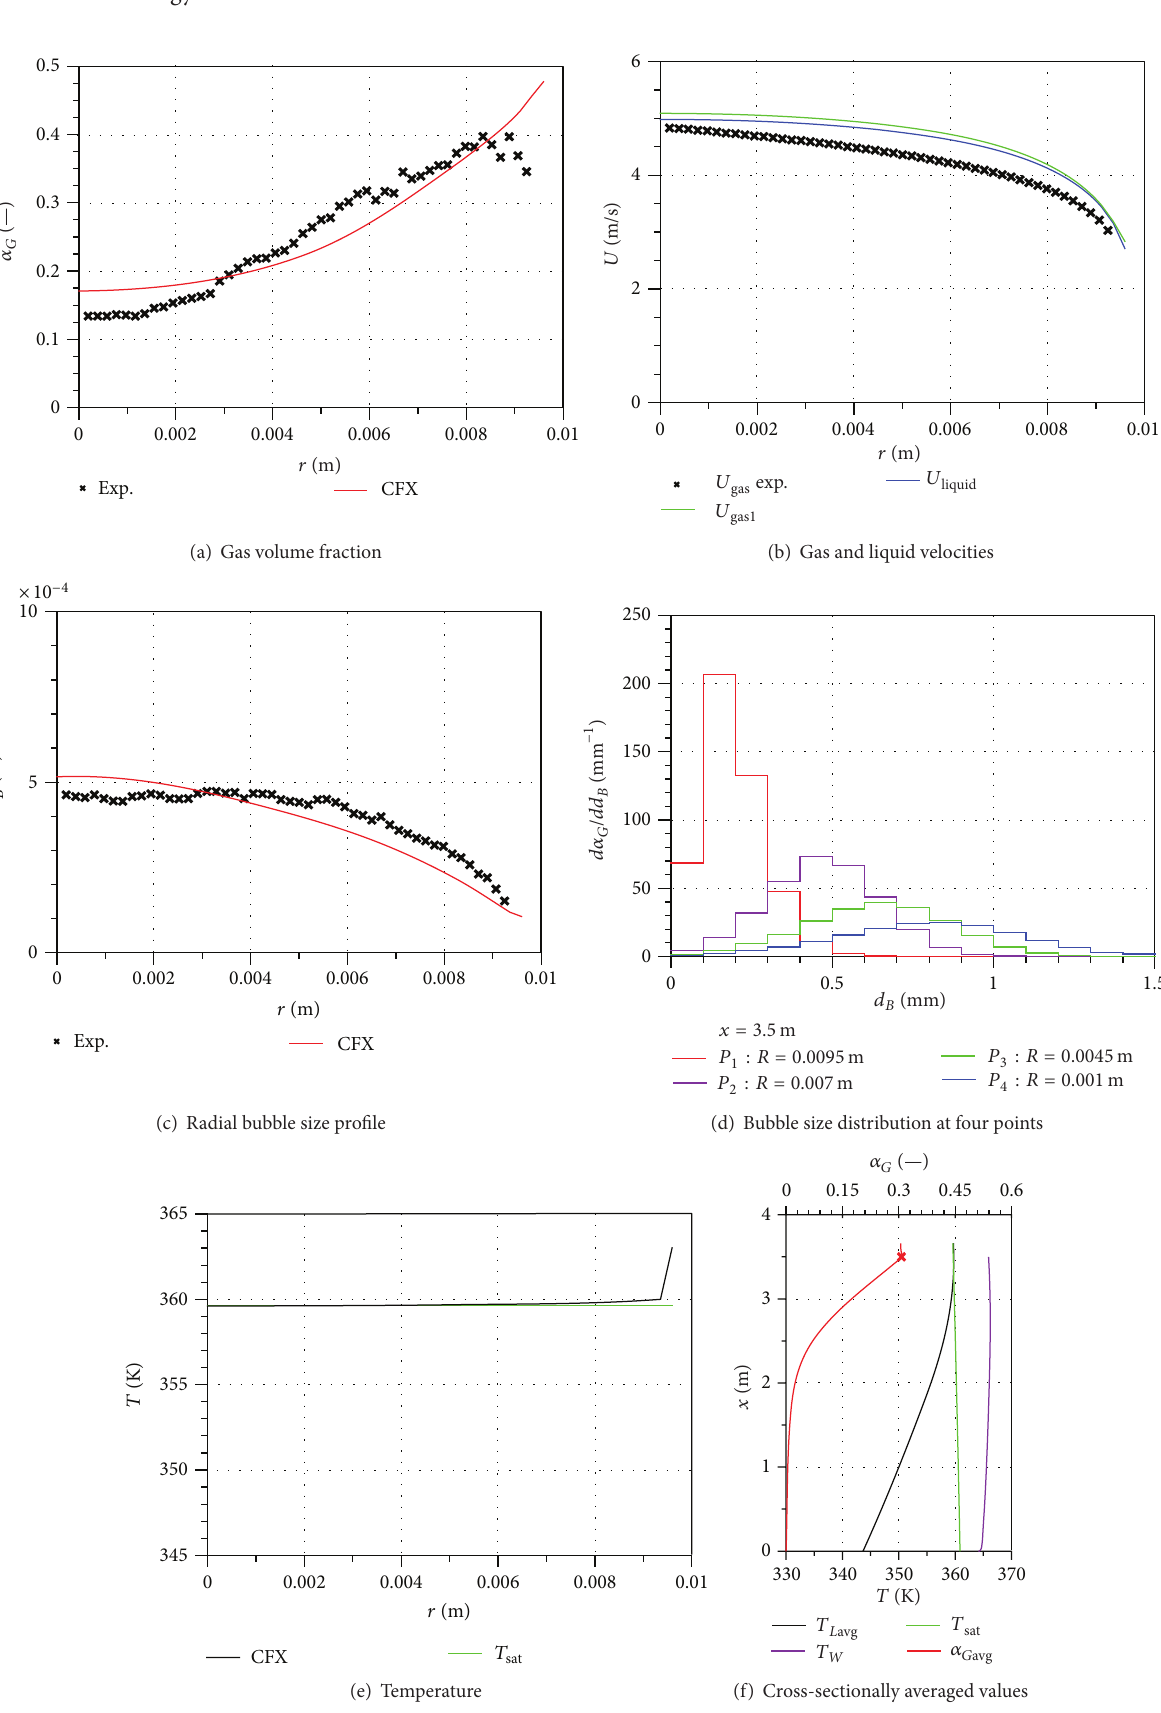
F 7: Comparison of measured and calculated values for